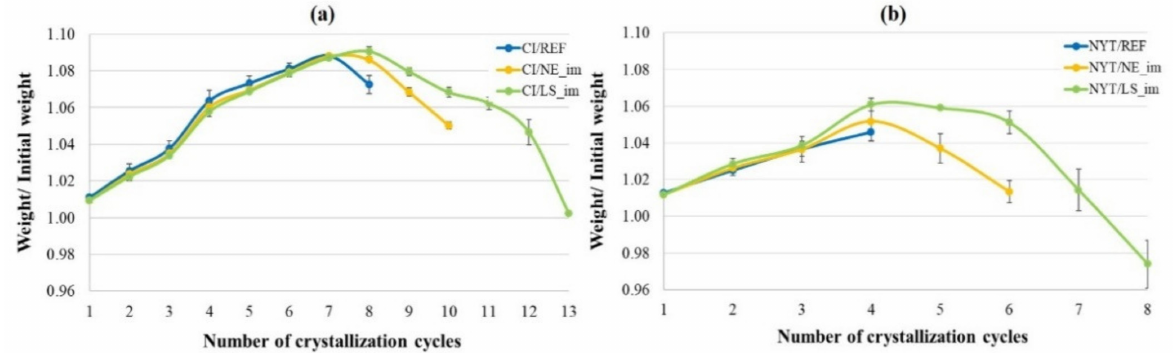
Figure 11. Salt crystallization resistance results of CI ( a ) and NYT ( b ) after aging test.